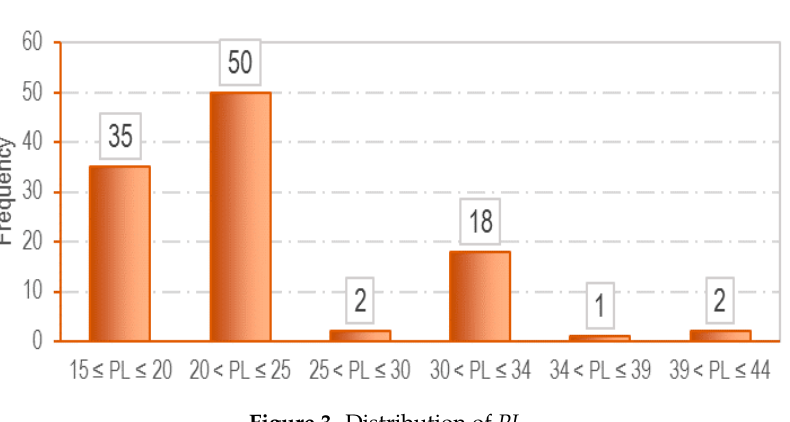
Figure 3. Distribution of PL .